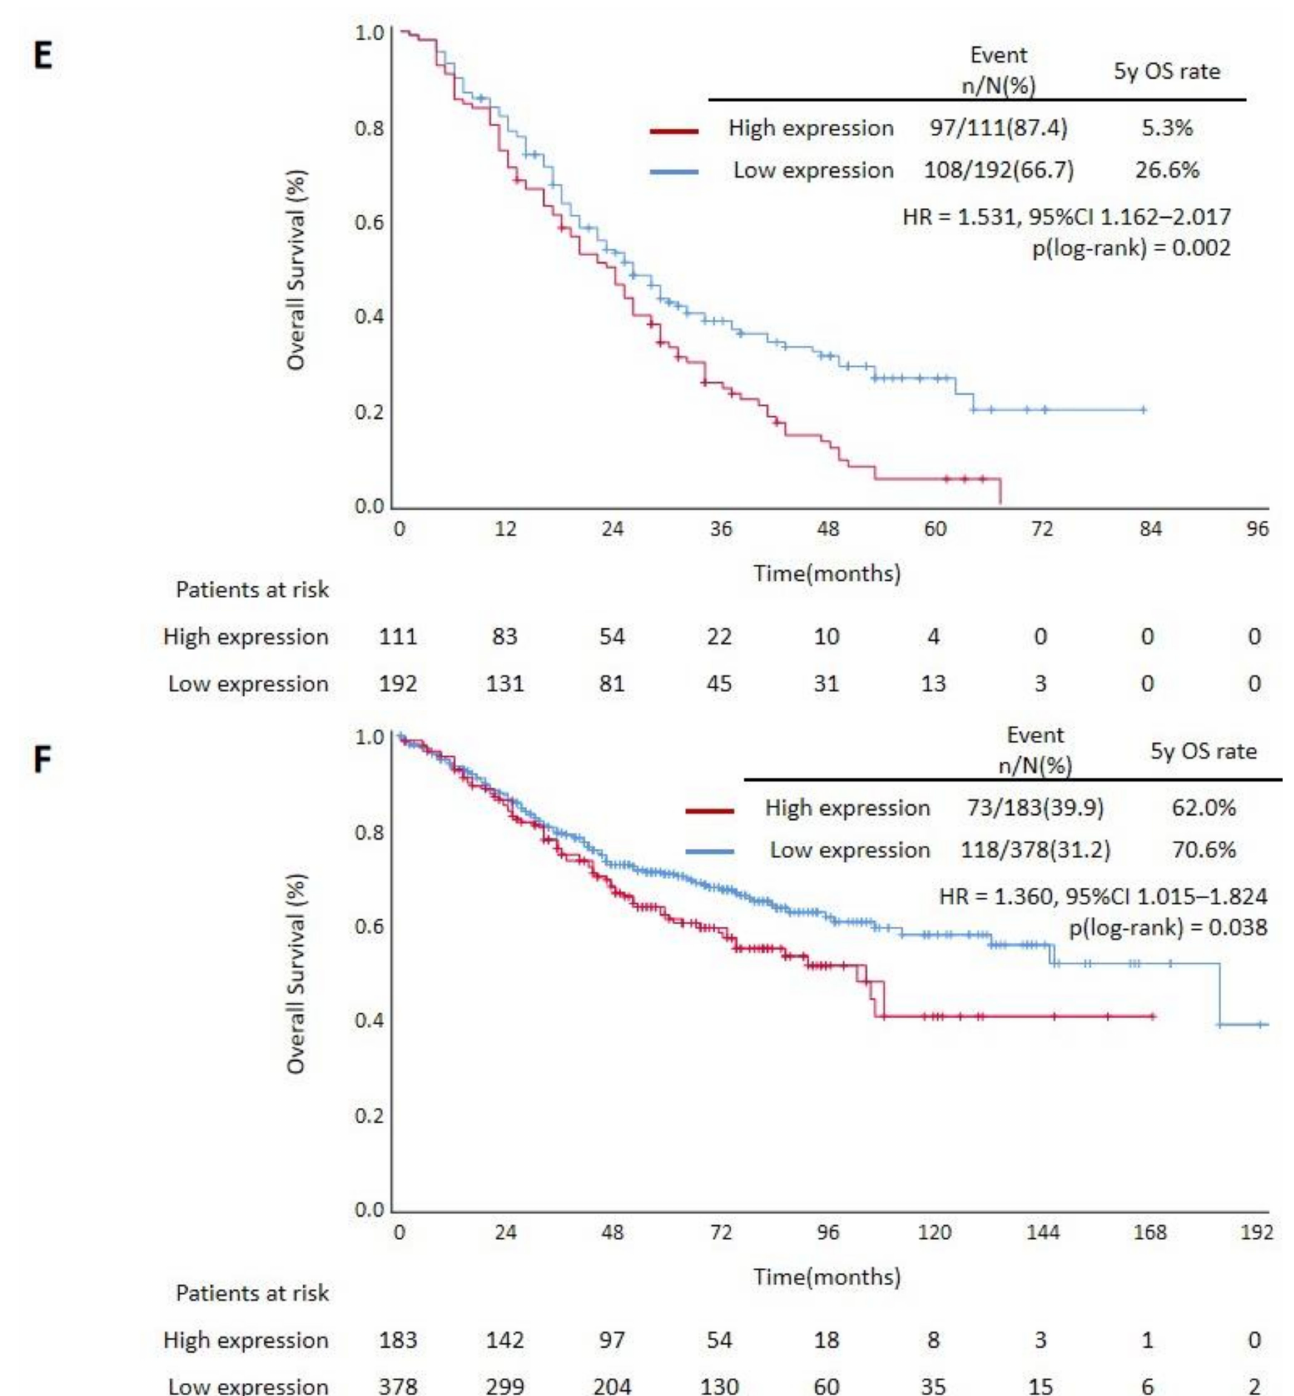
Figure 2. Kaplan–Meier curves of OS stratified by CUL9 expression: ( A ) all patients; ( B ) stage I patients; ( C ) stage II patients; ( D ) stage III patients; ( E ) stage IV patients; ( F ) all patients in the validation cohort; HR, hazard ratio; CI, confidence